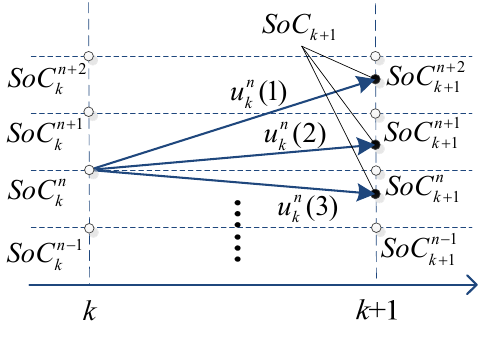
Figure 8. The interpolation diagram during the backward